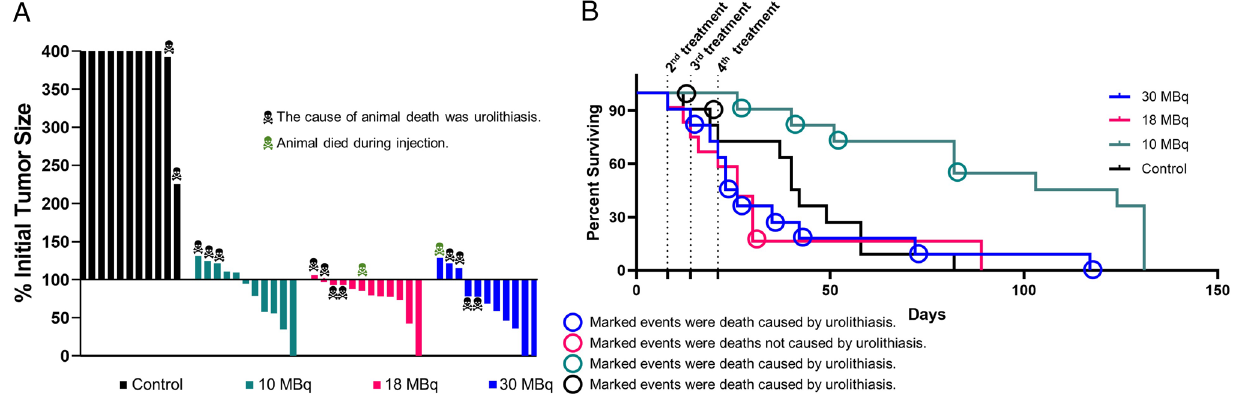
Figure 5. Evaluation of the therapeutic efficacy of four doses of iso -[ 131 I]SGMIB-VHH_1028 in SCID mice with subcutaneous BT474 xenografts. ( A ) Maximum tumor response waterfall plot. ( B ) Kaplan–Meier survival plot. The 4 treatment times are as marked with the first given at Day 0. Animal deaths due to urolithiasis related to ER pellet implantation are